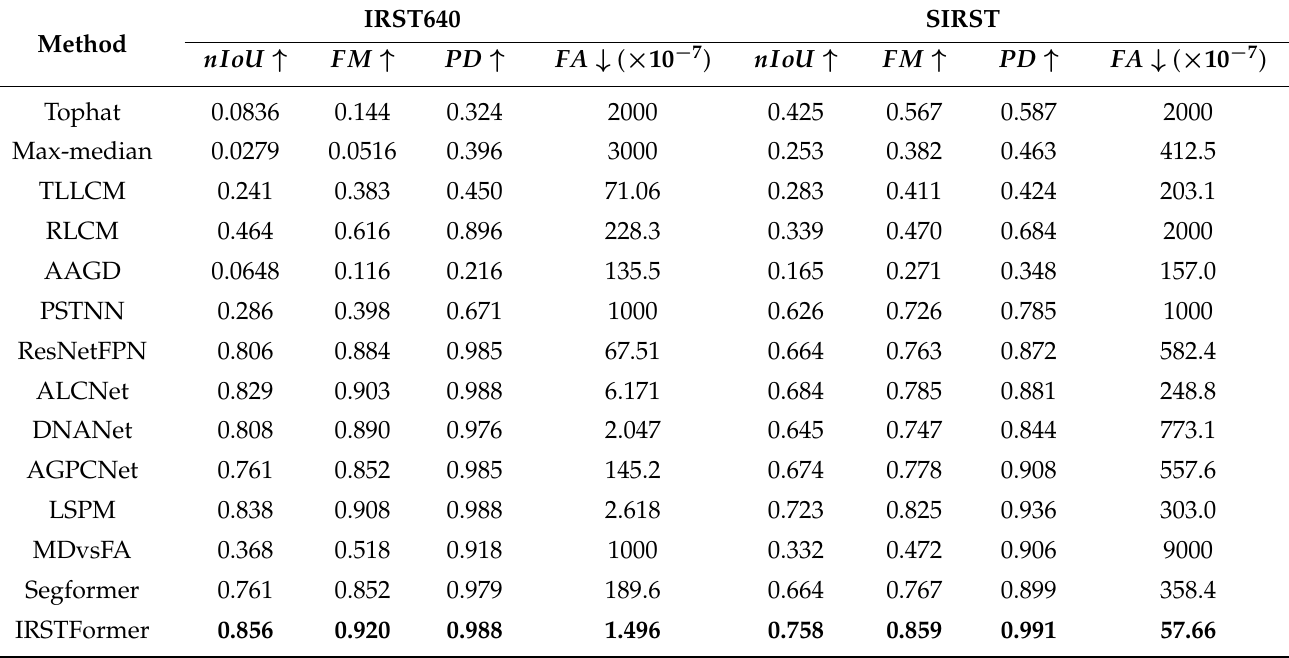
Table 1. The comparison results on the IRST640 and SIRST dataset with pixel-level and target-level